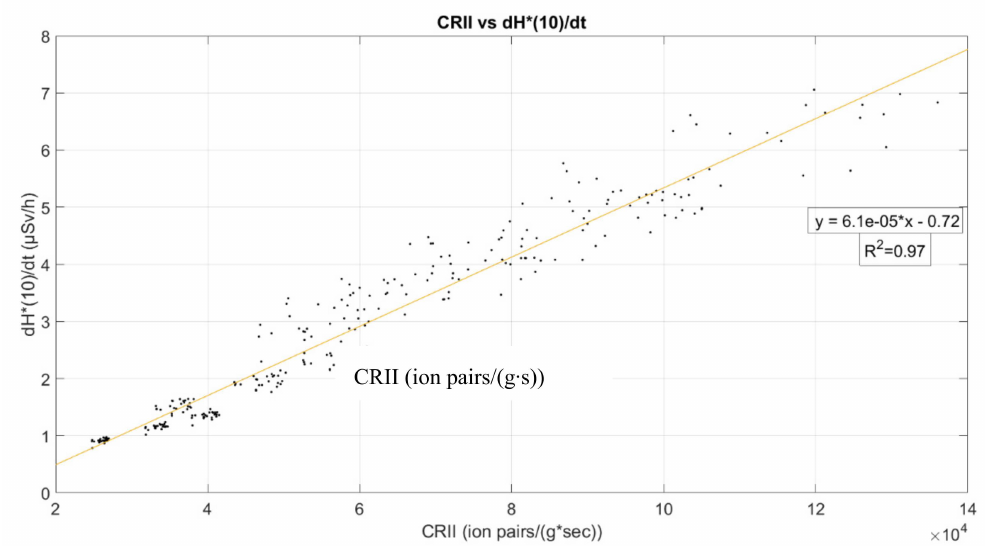
Figure 5. Scatter plot of the yearly distribution of the CRII and the ambient dose equivalent rate for the time period 1996–2019 for FL310, FL350,